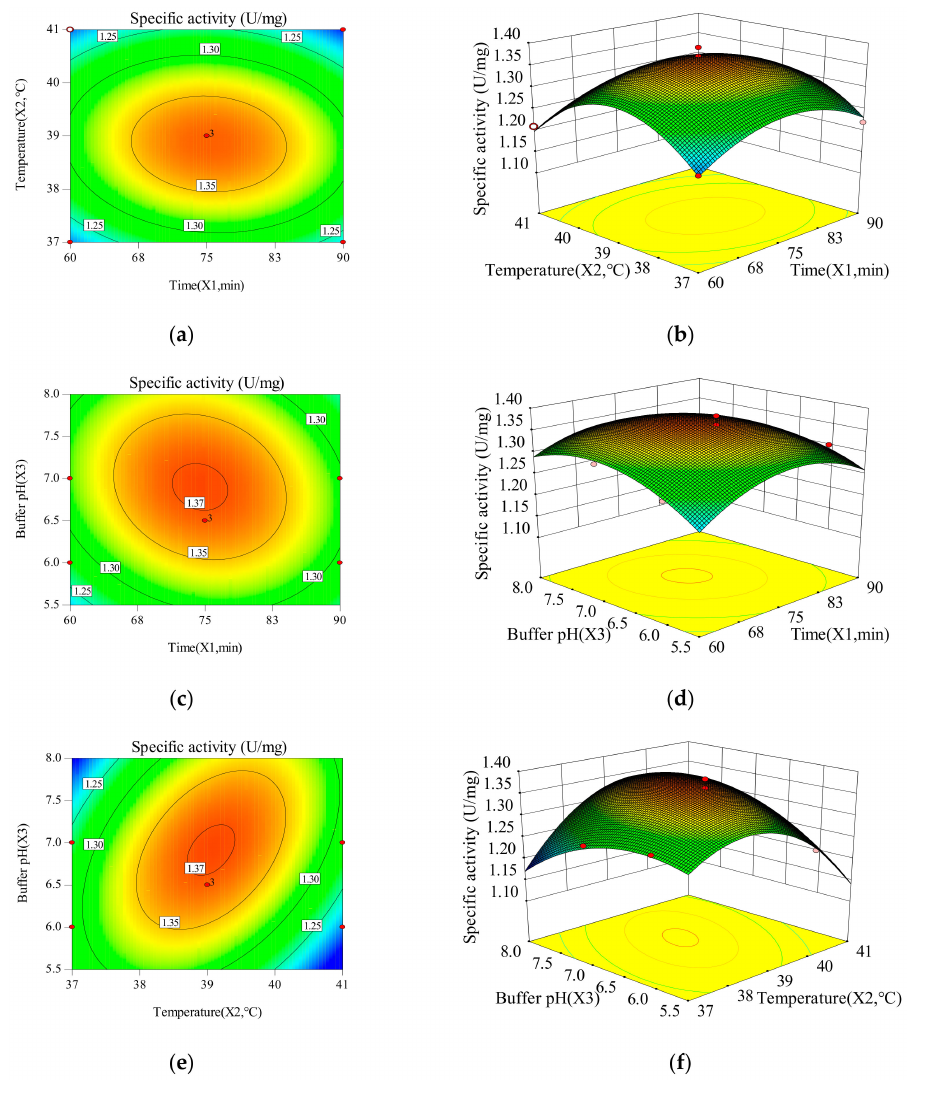
Figure 2. Contour plot of ( a ) time ( X 1 ) and temperature (X 2 ); ( b ) time ( X 1 ) and buffer pH ( X 3 ); ( c ) temperature ( X 2 ) and buffer pH ( X 3 ) and 3D plot of ( d ) time ( X 1 ) and temperature ( X 2 ); ( e ) time ( X 1 ) and buffer pH ( X 3 ); ( f ) temperature ( X 2 ) and buffer pH ( X 3 ) on specific activity of CEP from L. plantarum